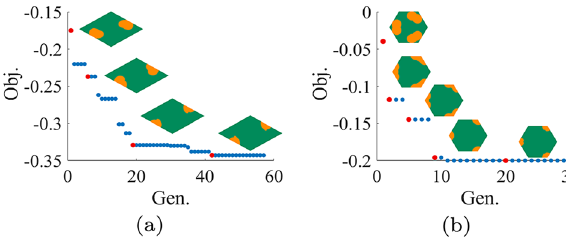
Figure A2: Iteration histories of the optimized diamond TCI with C 2 -symmetry and the optimized C 3v -symmetric hexagonal TCI.